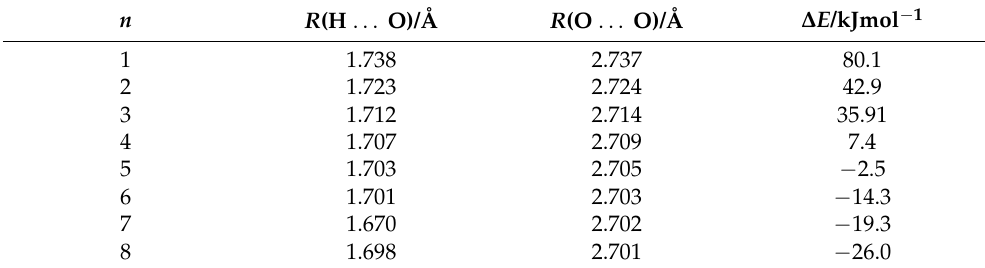
Table 1. Binding energies ∆ E and intermolecular distances R (H . . . O) of the optimized cationic dimers (HOOC–(CH 2 ) n –py + ) 2 with n = 1–8 calculated at the B3LYP–D3/6–31+G* level of